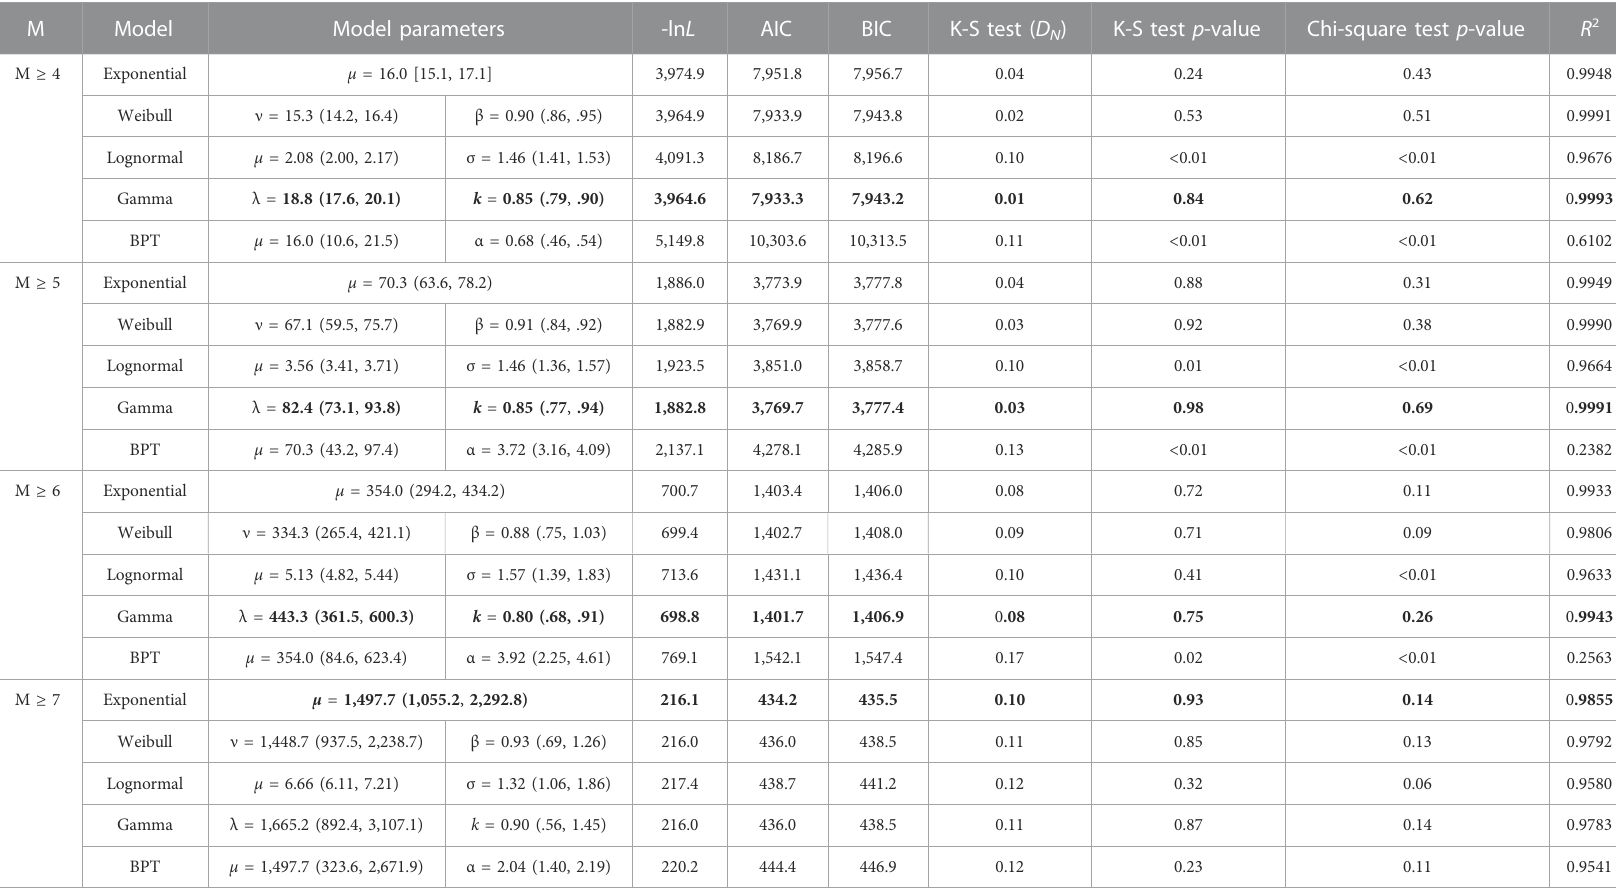
The best model using bold